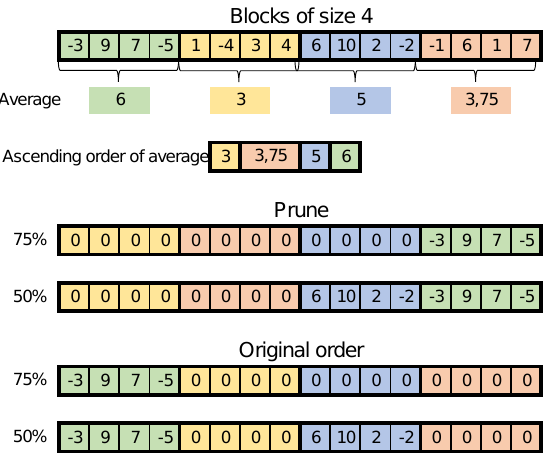
Figure 9. Pruning method for blocks of four weights.